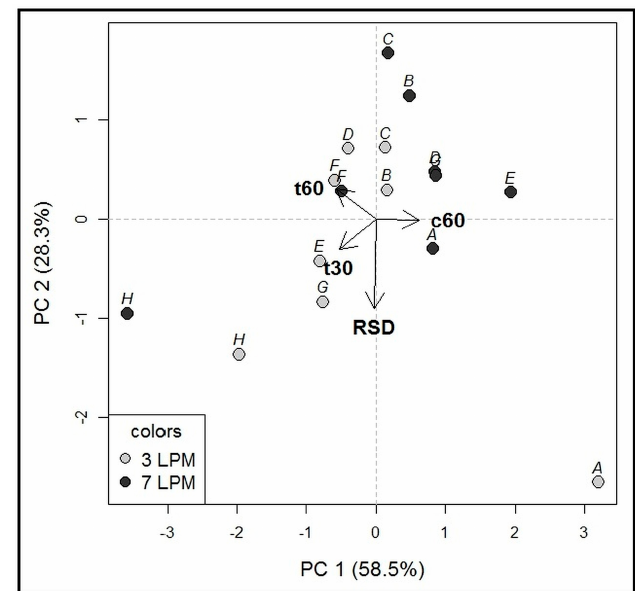
Figure 4. PCA biplot for Phase 1 (250 mL volume). Objects included in the model: eight dissolution compartment types (designated A-H), two agitation rates—7 and 3 LPM. Variables included in the model: t30, t60, c60, and median RSD. The first two principal components (PC1, PC2) explain 86.8% of the total variability, which is sufficient [18]. The PC1 was predominantly associated with the c60 (positive loadings), while the PC2 was mainly influenced by median RSD (negative loadings).